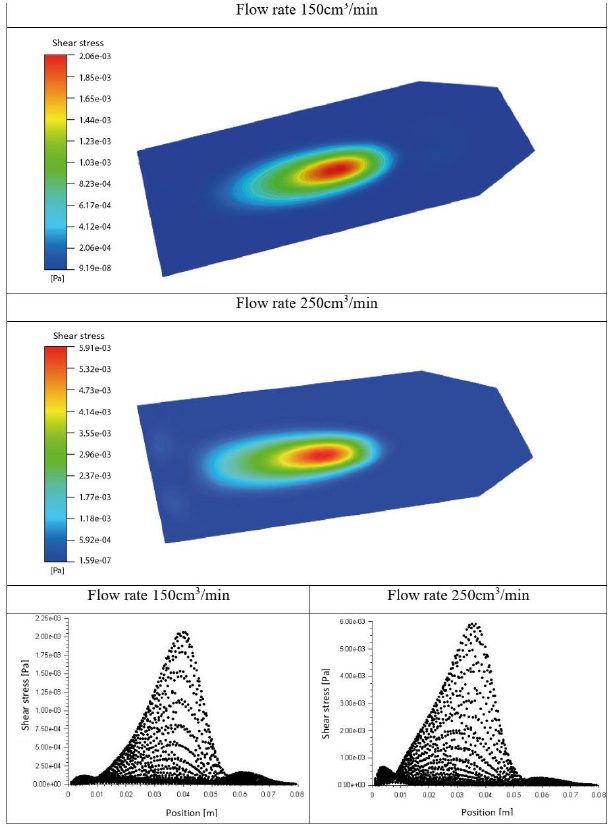
Fig. 5. Maps and diagrams of shear stress distribution on the bottom wall of the test specimen for model 1 The lowest stress values were observed for model 3, in which the designed tubing were directed upwards. On the basis of the analysis performed, it was concluded that the direction of aspiration tubing has an influence on the values of shear stresses. Reducing the flow rate to 150 cm 3 /min will reduce the shear stress values several times. Directing the inlet aspiration tubing towards the top of the sampler or cutting its tip at an angle leads to a more uniform distribu- tion of shear stresses on the bottom wall of the